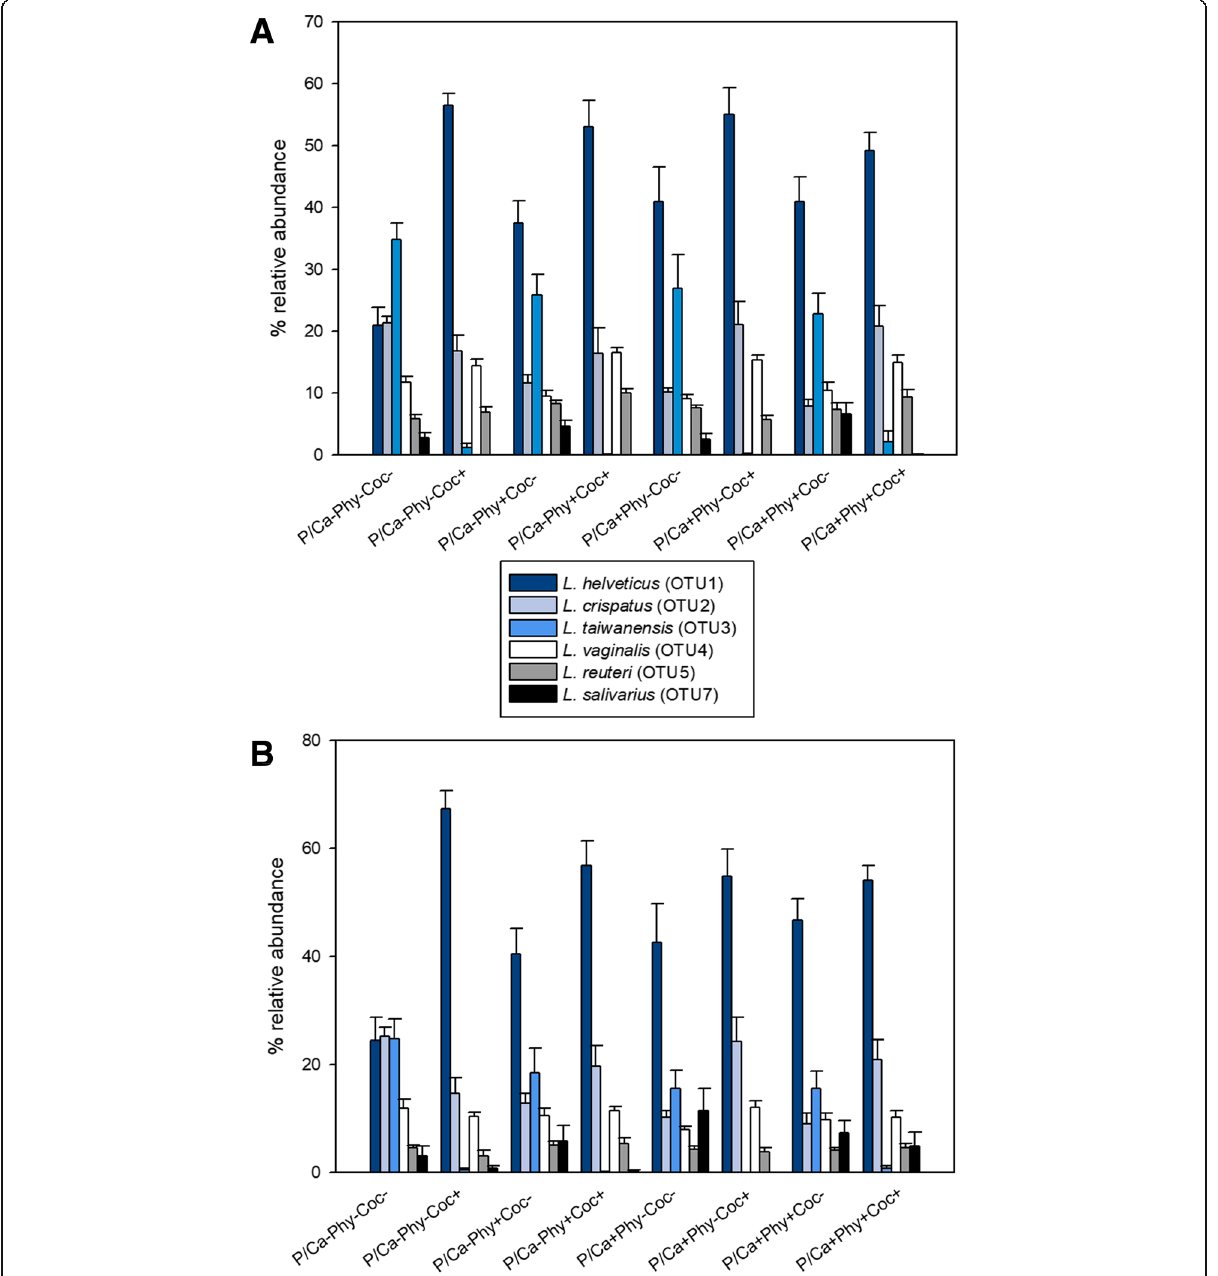
Fig. 3 Relative abundance of most abundant Operational Taxonomic Units (OTUs). The assigned OTUs correspond to Lactobacillus genus, found in the crop ( a ) and ileum ( b ) digesta samples. Error bars indicate standard deviation of the